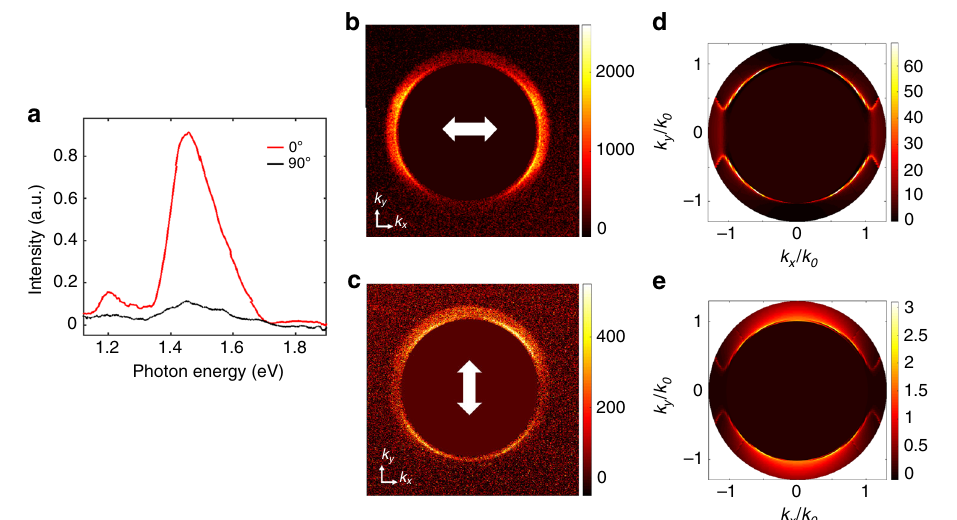
Fig. 5 Polarization-dependence of the ASPEIT junction. a SPP emission spectra with two different polarized directions (0° stands for the direction, which is perpendicular to the long wire patch antenna, while 90° stands for the direction that is parallel to the wire.) b , c Back focal plane image, showing the plasmon emission between k / k 0 = 1.0 and k / k 0 = 1.3, with two different polarization direction of 0° and 90° (the white arrows indicate the polarization direction). d , e Simulated back focal plane images (at 1.45 eV and D = 132 nm) associated with the fi gure ( b , c